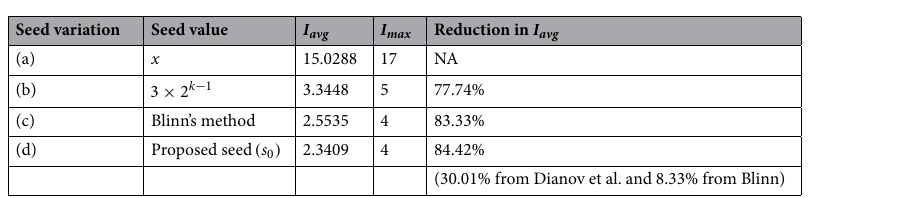
Table 8. Impact of different seed selections on the number of iterations for Newton–Raphson’s method using an accuracy of four decimal digits.